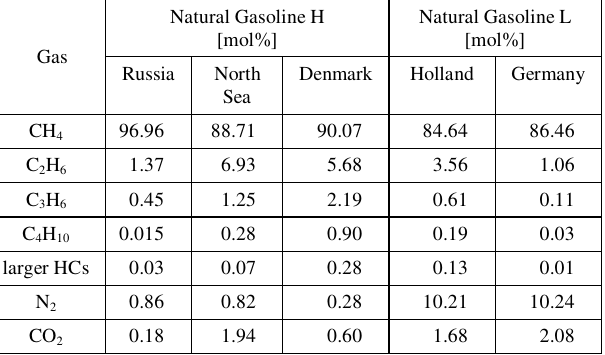
Table 1. Main components of natural gas blends at different locations [6]